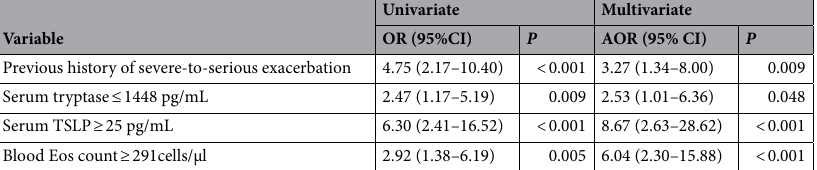
Table 3. Significant factors associated with asthma exacerbation (n = 132). EOS eosinophil, TSLP thymic stromal lymphopoietin.